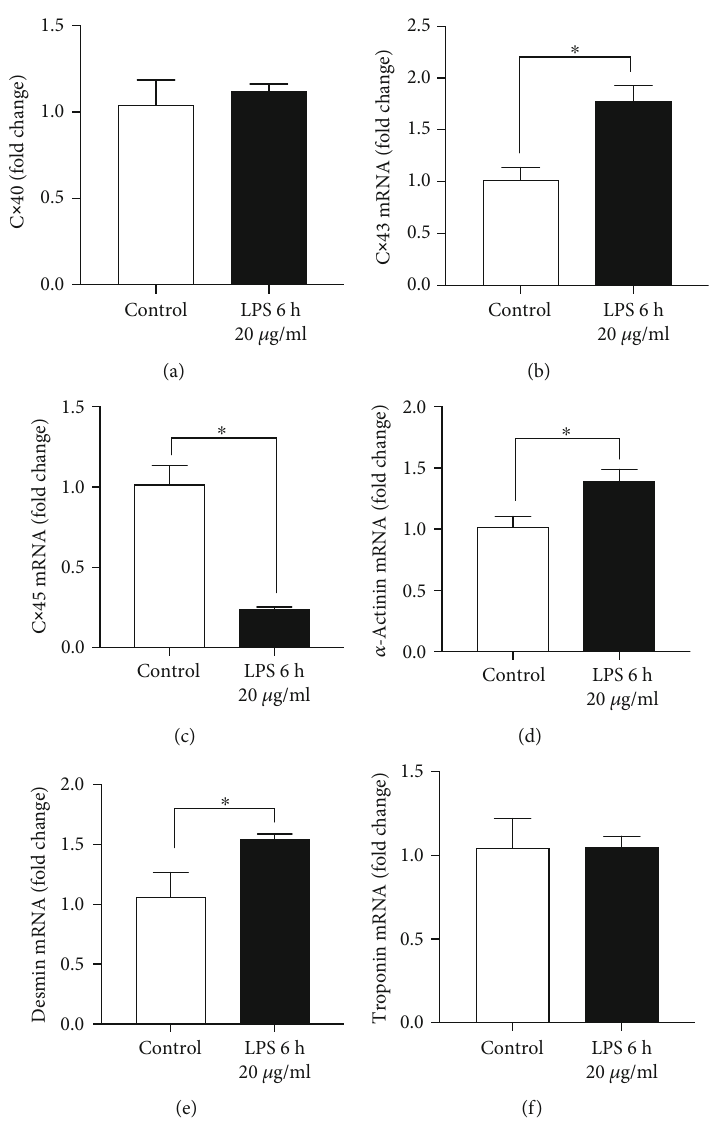
Figure 5: Gene expression in HL-1 cells in presence of LPS. mRNA expression of connexin 40 (Cx40) (a), connexin43 (Cx43) (b), connexin 45 (Cx45) (c), α -actinin (d), desmin (e), and troponin I (f). Results are presented as mean fold change. HL-1 cells were treated with 20 μ g/ml LPS for 6h (black bars). The control group was incubated in a cell culture medium without any supplements (white bars). n = 6 per each group; ∗ p < 0 : 05 . All values are expressed as mean ± SEM